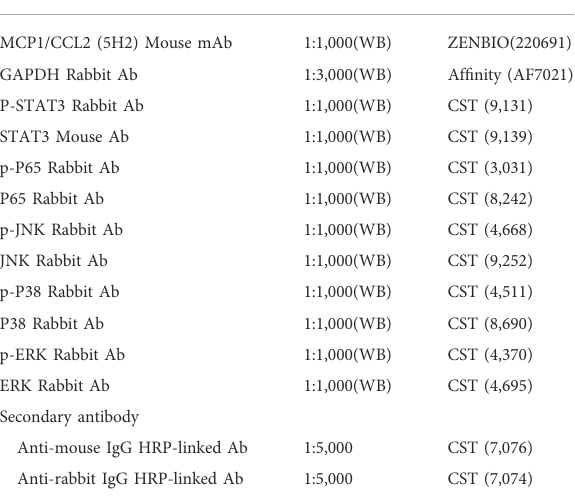
TABLE 1 Antibody information used in the article. TABLE 2 Antibody information used in the